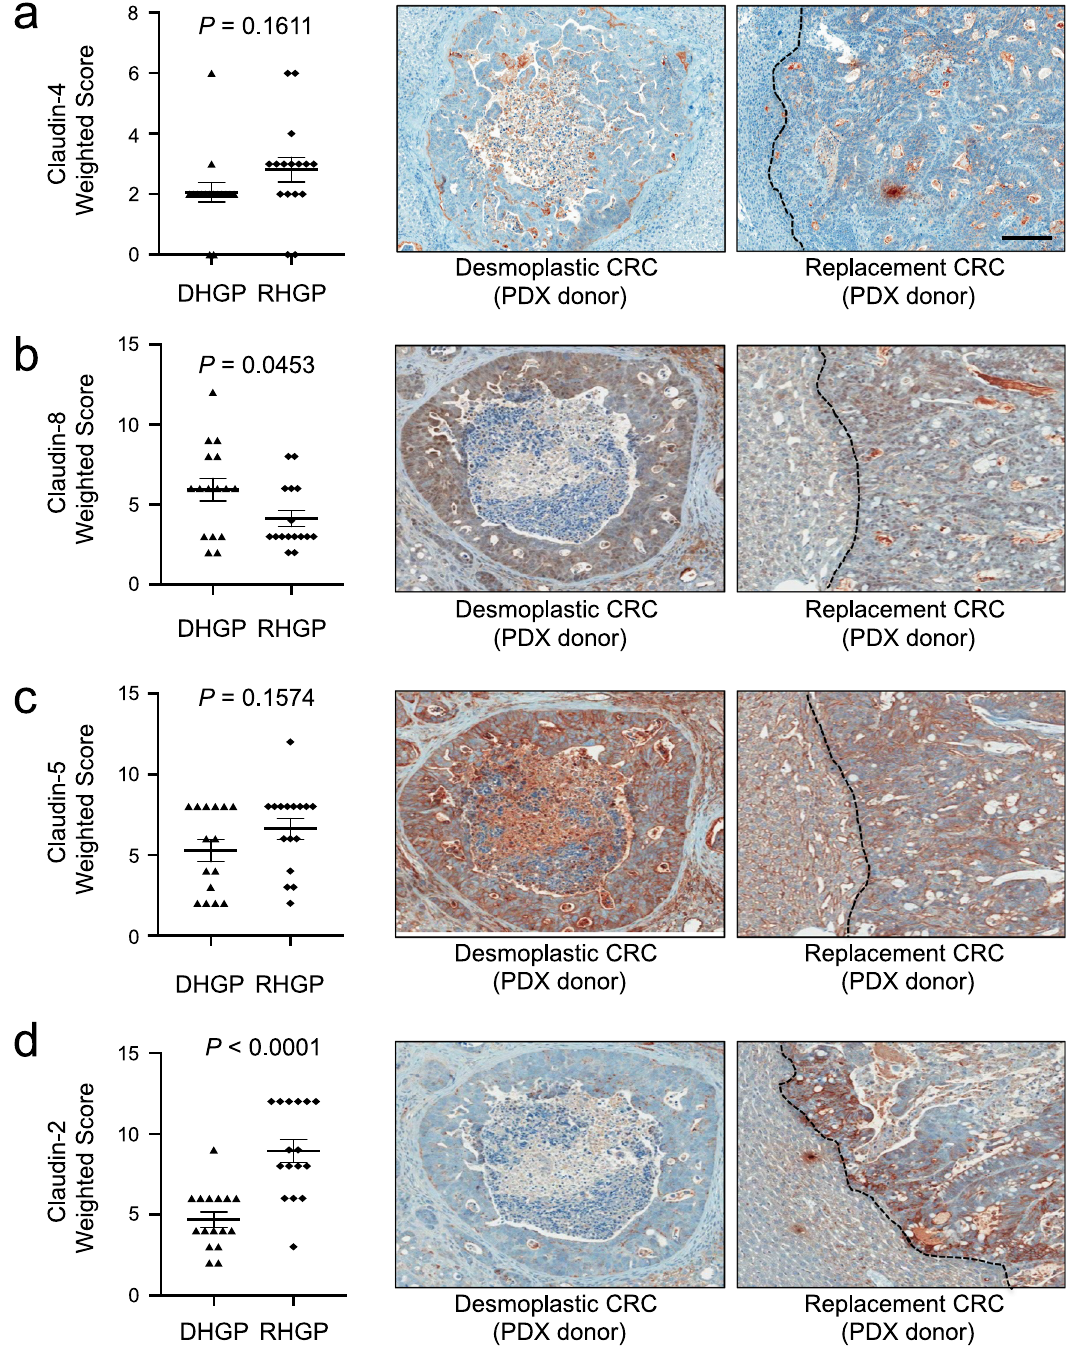
Fig. 5 Claudin-2 is enriched in the PDXs derived from replacement-type liver metastases. a – d Paraf fi n embedded sections from established intrahepatic PDXs from either DHGP- or RHGP-type lesions were subjected to immunohistochemical staining with anti-Claudin-4 ( a ), anti-Claudin-8 ( b ), anti-Claudin- 5 ( c ), or anti-Claudin-2 ( d ) antibodies. Claudin-8 expression is signi fi cantly enriched in the desmoplastic-type liver metastases. In contrast, Claudin-2 expression is signi fi cantly increased in the replacement-type liver metastases. Representative images of Claudin-4, Claudin-8, Claudin-5, or Claudin-2 staining are shown. Scale bar = 100 μ m and applies to all panels. Scoring of IHC staining was performed by two independent pathologists (AO and AG). Data are presented as the mean ±